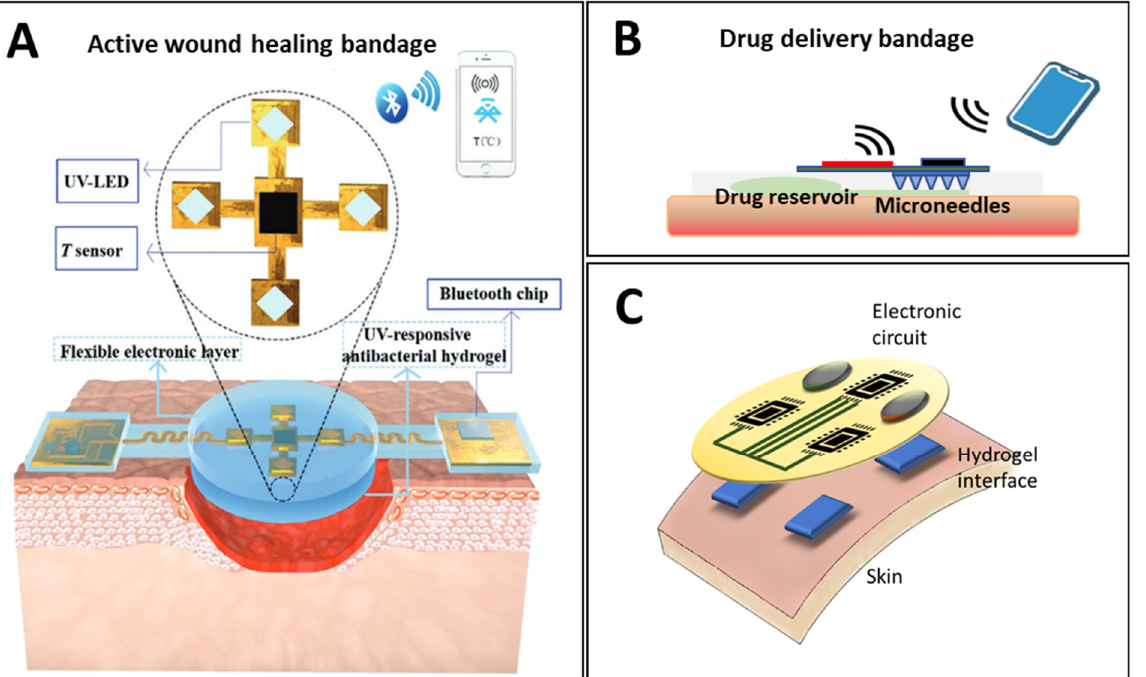
Figure 10. Responsive smart bandages with drug delivery capability by external and internal stimuli, ( A ). Externally triggered wound dressing: the on-demand release of therapeutic agents is activated through UV irradiation of a UV-responsive anti-bacterial hydrogel. Reproduced under the CC-BY license [83]. ( B ). Bandages-based drug delivery system layout. ( C ). Smart bandage with integrated biochemical sensors, stimulators and hydrogel interface for advanced wound care and accelerated healing.